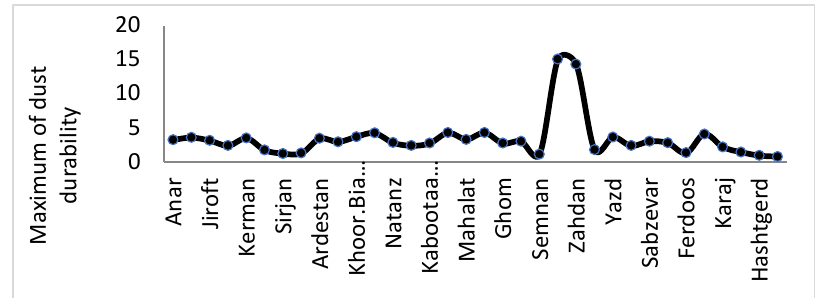
Figure 8. Graph of average dust day durations by station in the study area . Then, using GIS software and the kriging interpolation method, the maximum, minimum and average annual-maximum DDD over 1999–2018 were mapped in Figure 9, Figure 10 and Figure 11, respectively.